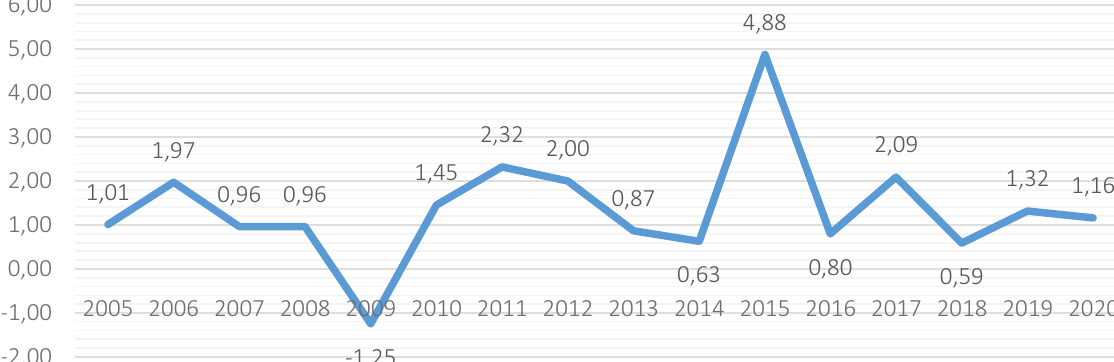
Figure 2. The ratio of growth rates of the monetary aggregate M3 and the monetary base